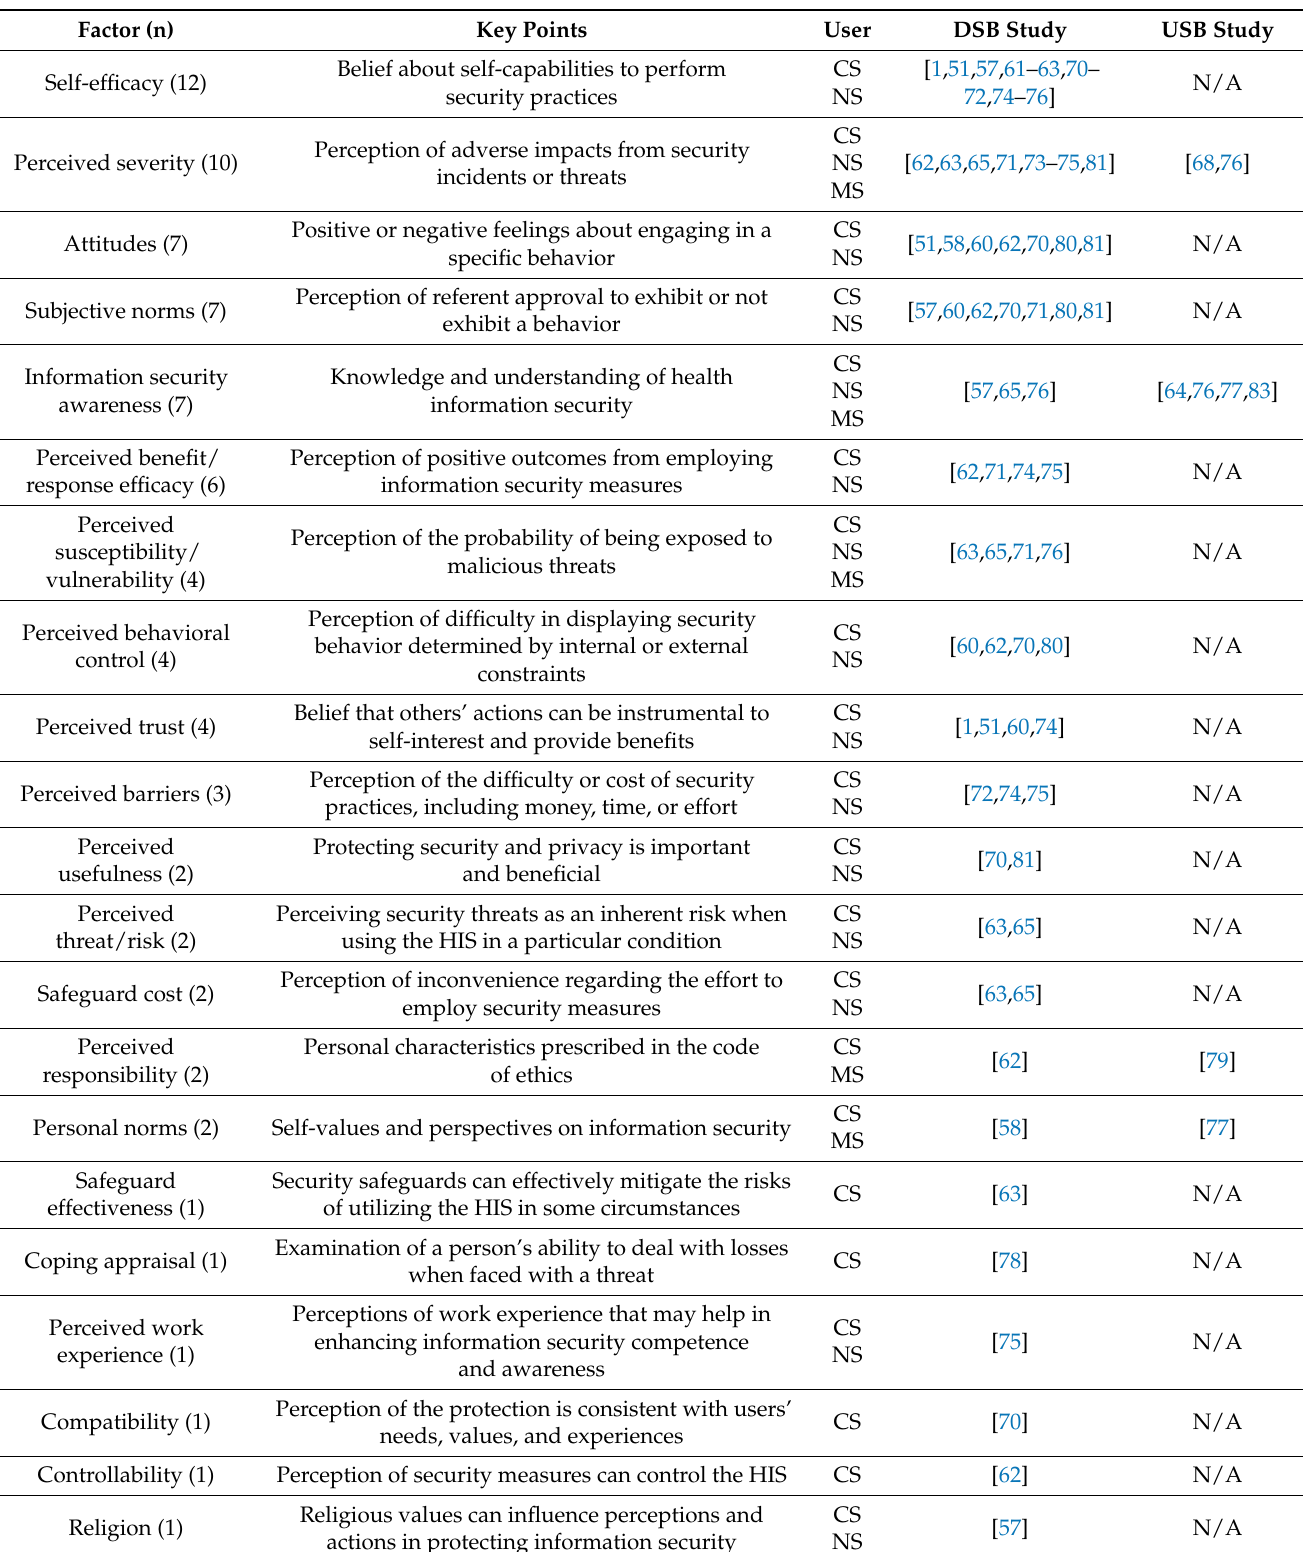
Table 8. Individual factors as antecedents of security